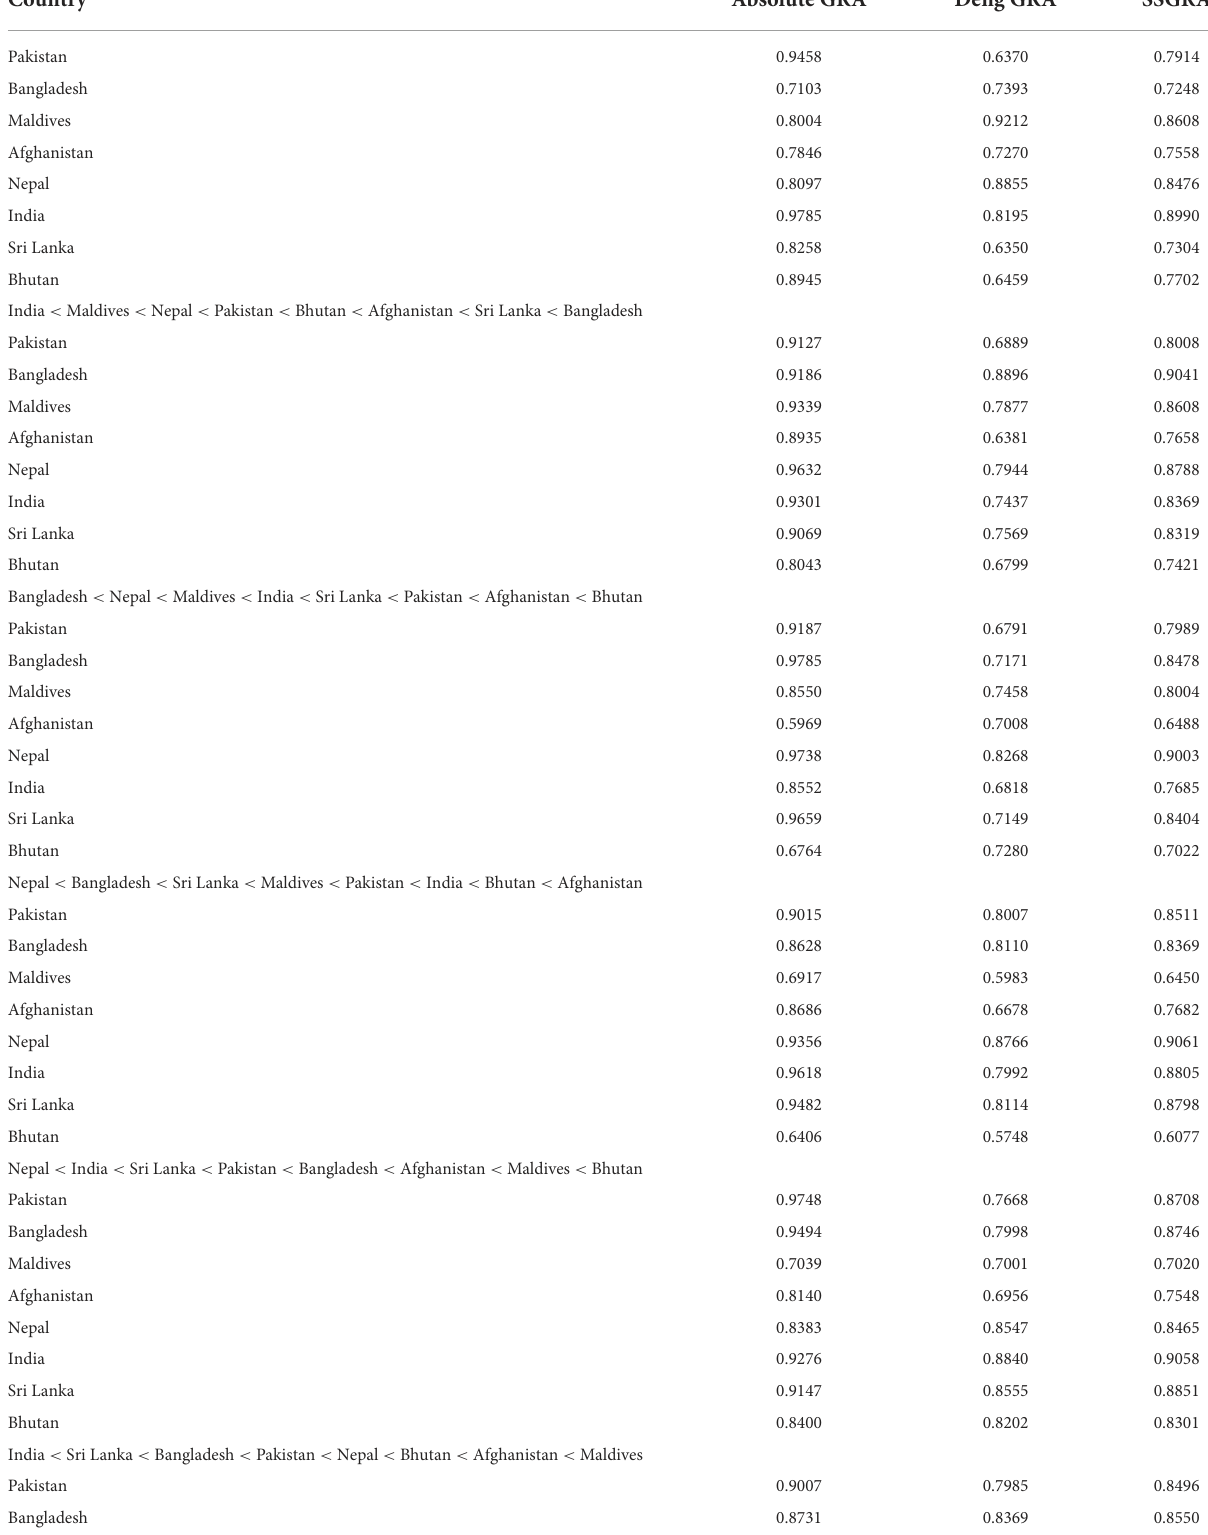
TABLE 2 Grey assessment between cardiac risk factors and associated mortality. Country Absolute GRA Deng GRA